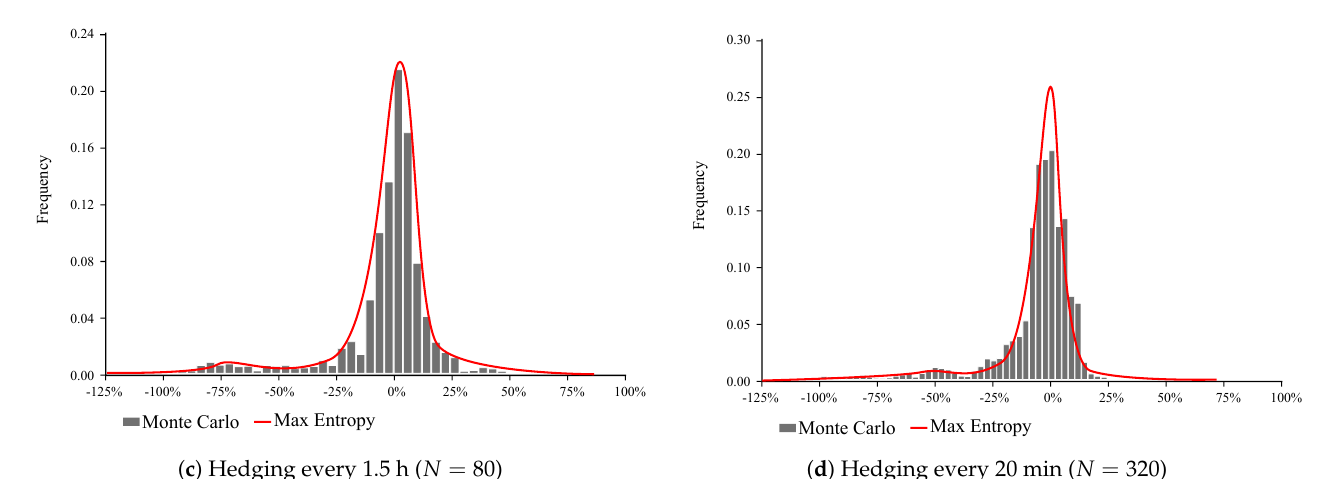
Figure 1. Distribution of hedging error of a one-month European call option under the Weighted Gamma, obtained using Monte Carlo simulation and computing Max Entropy estimation.